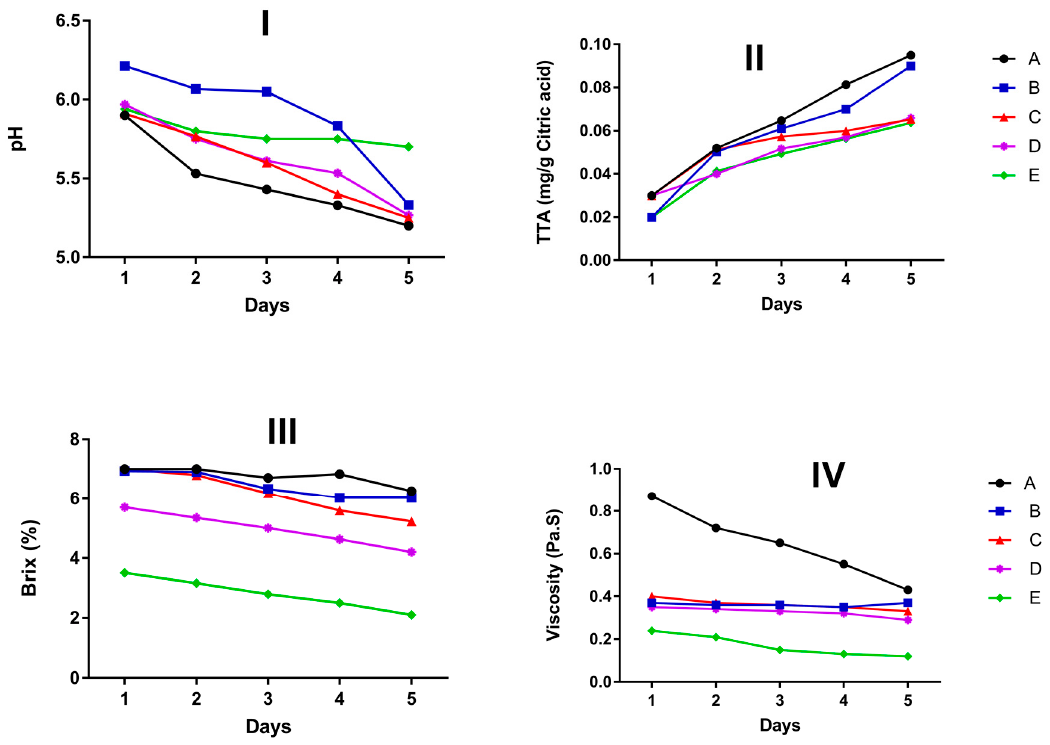
Figure 1. The pH ( I ), total titratable acidity (TTA) ( II ), Brix ( III ) and viscosity ( IV ) of carrot- cucumber